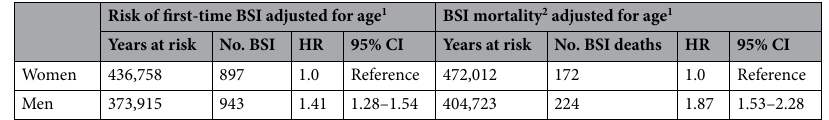
Table 2. Associations of sex with risk of bloodstream infection and BSI mortality. BSI bloodstream infection, HRs hazard ratios, 95% CI 95% confidence intervals, No. numbers. 1 Cox regression analyses were adjusted with age as the underlying scale. 2 BSI mortality was defined as all-cause mortality within 30 days after a bloodstream infection.